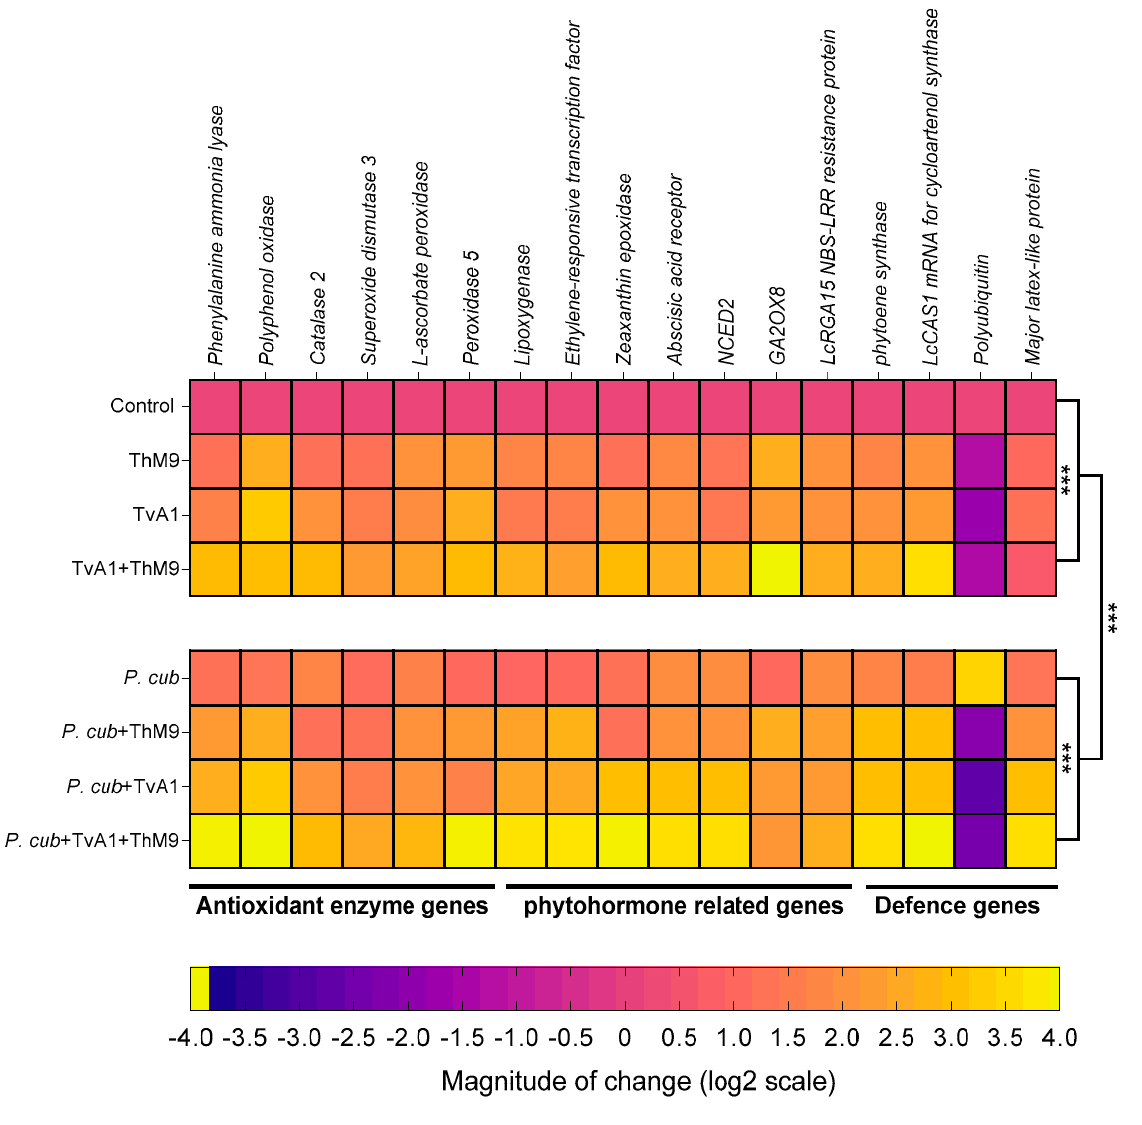
Figure 9. Expression profiling of antioxidant enzymatic genes, phytohormonal biosynthesis, and signaling genes and defense-related genes in luffa leaf upon co-inoculation of the fungal isolates (ThM9 and TvA1) and pathogen ( P. cubensis ) by RT-qPCR. Quantitative data represent the means ± SD (n = 12) of three independent experiments. The asterisks indicate a significant difference between treated samples compared to control (*** p ≤ 0.005).